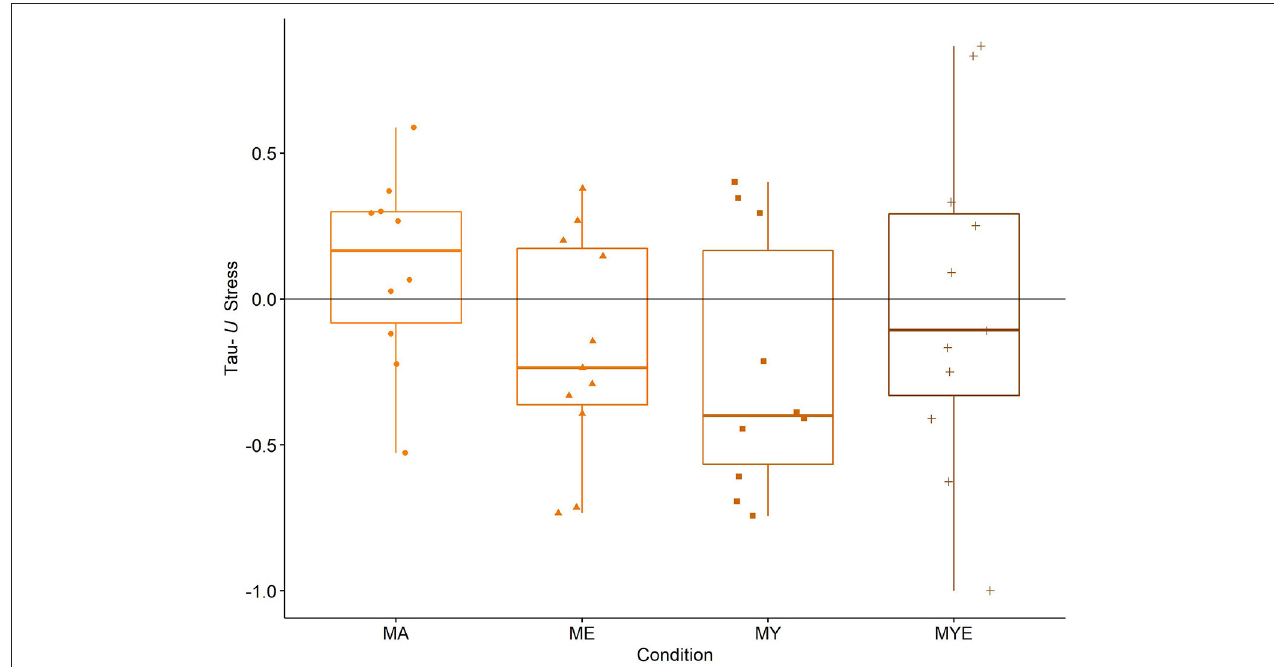
FIGURE 6 | Box Plots for averaged Tau- U stress estimates in each condition. Individual stress estimates are scattered across the box plots. MA, Mantra meditation only; ME, meditation and ethical education; MY, meditation and physical yoga; MYE, meditation, physical yoga, and ethical education. Whiskers represent the largest and lowest values within a distance of 1.5 times the interquartile